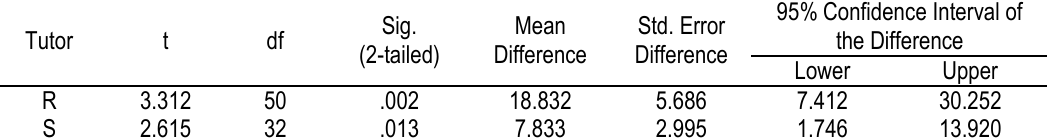
95% Confidence Interval of the DifferenceTutor t df